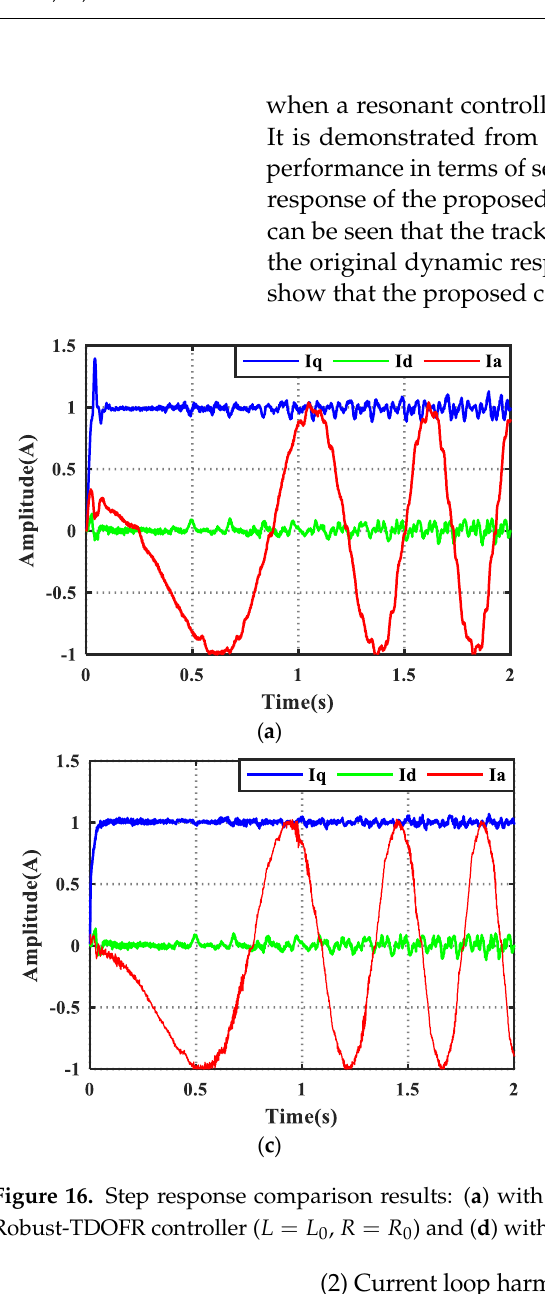
Figure 15. Structural diagram of the PMSM servo system.